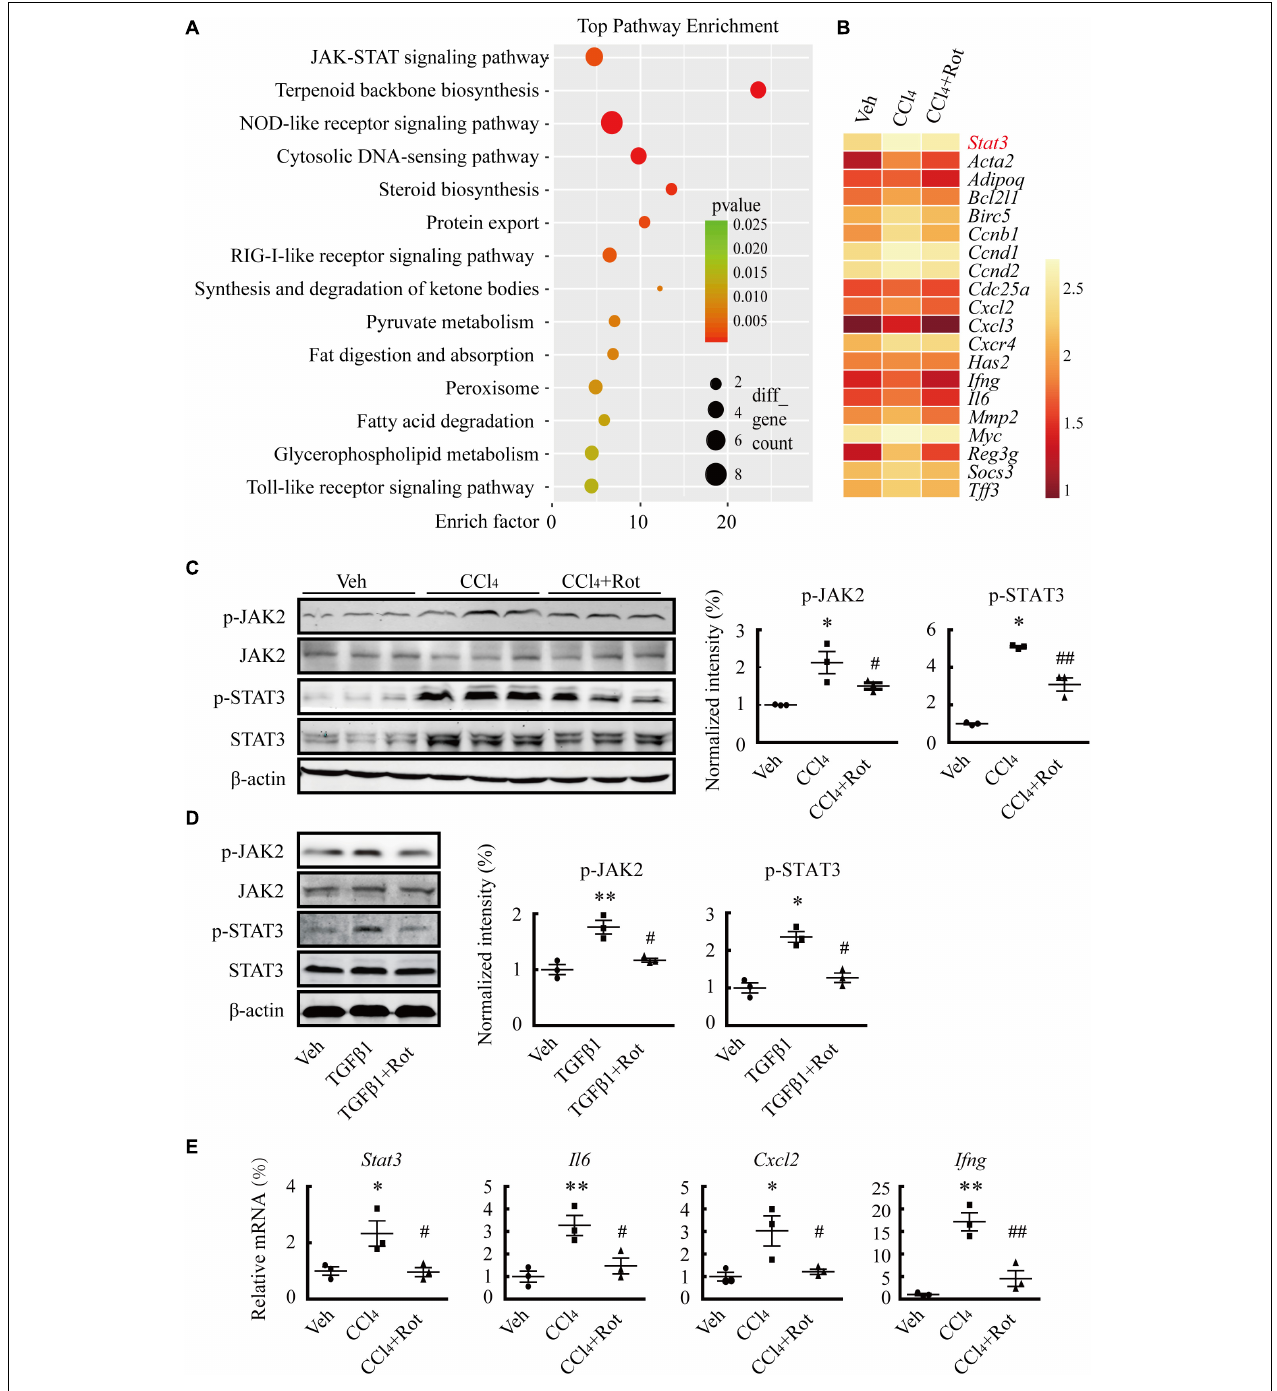
FIGURE 6 | Rottlerin treatment suppresses the JAK/STAT3 signaling pathway. (A) KEGG (Kyoto Encyclopedia of Genes and Genomes) enrichment analysis showing the signaling pathways potentially involved in the antifibrotic effects of rottlerin in rats with CCl 4 -induced liver fibrosis ( n = 3). (B) cDNA microarray showing STAT3 and its downstream target genes in liver tissues of rats treated with vehicle, CCl 4 , or rottlerin, respectively. The average signal intensity was log2-transformed. (C) Representative western blots ( left ) and normalized intensity ( right ) of the total and/or phosphorylated proteins as indicated in liver tissues from vehicle, CCl 4 , and rottlerin + CCl 4 -treated rats ( ∗ p < 0.05 compared with the Veh group, # p < 0.05 and ## p < 0.01 compared with the CCl 4 -treated group, n = 3). (D) Representative western blots ( left ) and normalized intensity ( right ) of total and phosphorylated JAK2 and STAT3 in primary hepatic stellate cells (HSCs) treated as indicated. The phosphorylation levels of JAK2 and STAT3 were measured in serum-starved HSCs treated with TGF β 1 (4 ng/mL) for 4 h for. Rottlerin (3 µ M) was applied to the medium for 6 h before TGF β 1 application ( ∗ p < 0.05 and ∗∗ p < 0.05 compared with the Veh group, # p < 0.05 compared with the TGF β 1-treated group, n = 3). (E) mRNA levels of Stat3 and its downstream targets interleukin 6 ( Il6 ), C-X-C motif chemokine ligand 2 ( Cxcl2 ), and interferon gamma ( Ifng ) after rottlerin treatment in fibrotic rats ( ∗ p < 0.05 and ∗∗ p < 0.01 compared with the Veh group, # p < 0.05 and ## p < 0.01 compared with the CCl 4 -treated group, n = 3).